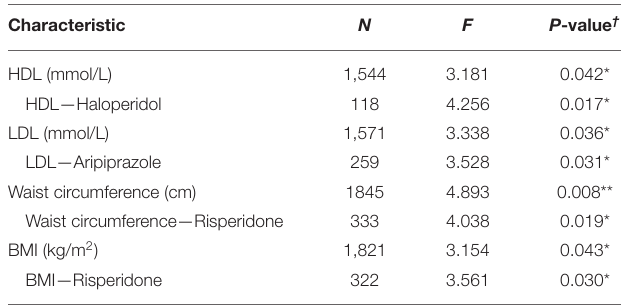
TABLE 3 | Association of MTHFR C677T polymorphism with antipsychotic-induced metabolic parameter change in patients with schizophrenia. Characteristic N